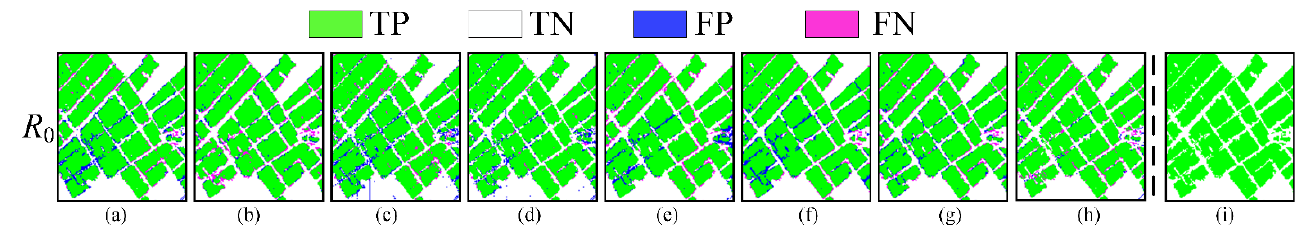
Figure 10. Detection details of the selected region R 0 on the China dataset using different methods: ( a ) CVA, ( b ) SSIM, ( c ) ISFA, ( d ) IRMAD, ( e ) MaxtreeCD, ( f ) Unet, ( g ) SGCL, ( h ) SSCF, ( i ) Ground- truth. Figure 11. Binary CM of the USA dataset using different methods: ( a ) CVA, ( b ) SSIM, ( c ) ISFA, ( d ) IRMAD, ( e ) MaxtreeCD, ( f ) Unet, ( g ) SGCL, ( h ) SSCF, ( i ) Ground-truth.